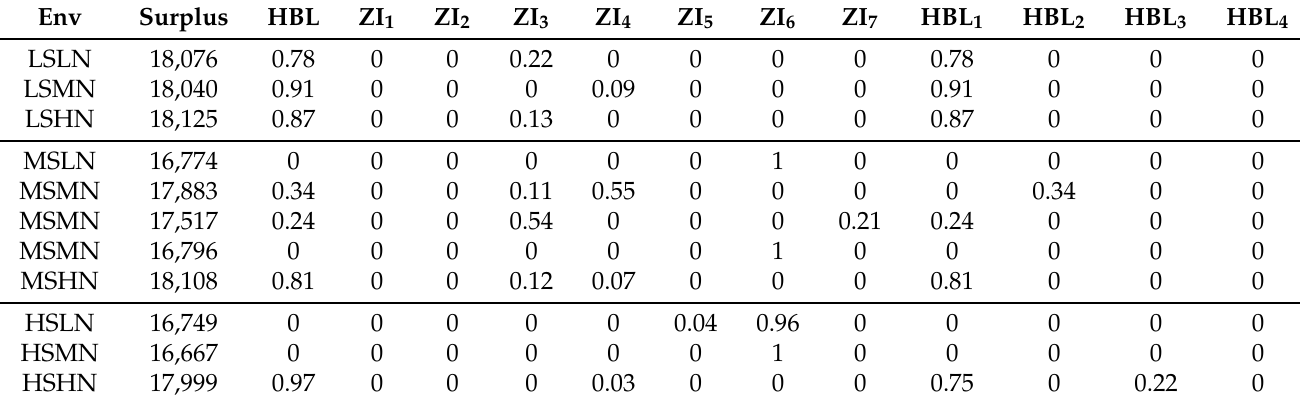
Table A7. Equilibria for games with spoofing, N = 28, calculated from the four-player DPR approximation. Each row of the table describes one equilibrium found with its corresponding surplus, HBL adoption rate and the equilibrium mixture probabilities of strategies